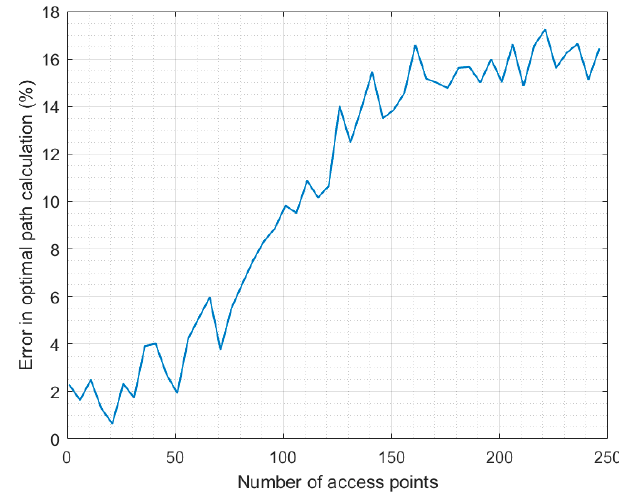
Figure 11. Fourth experiment: optimal path evaluation.